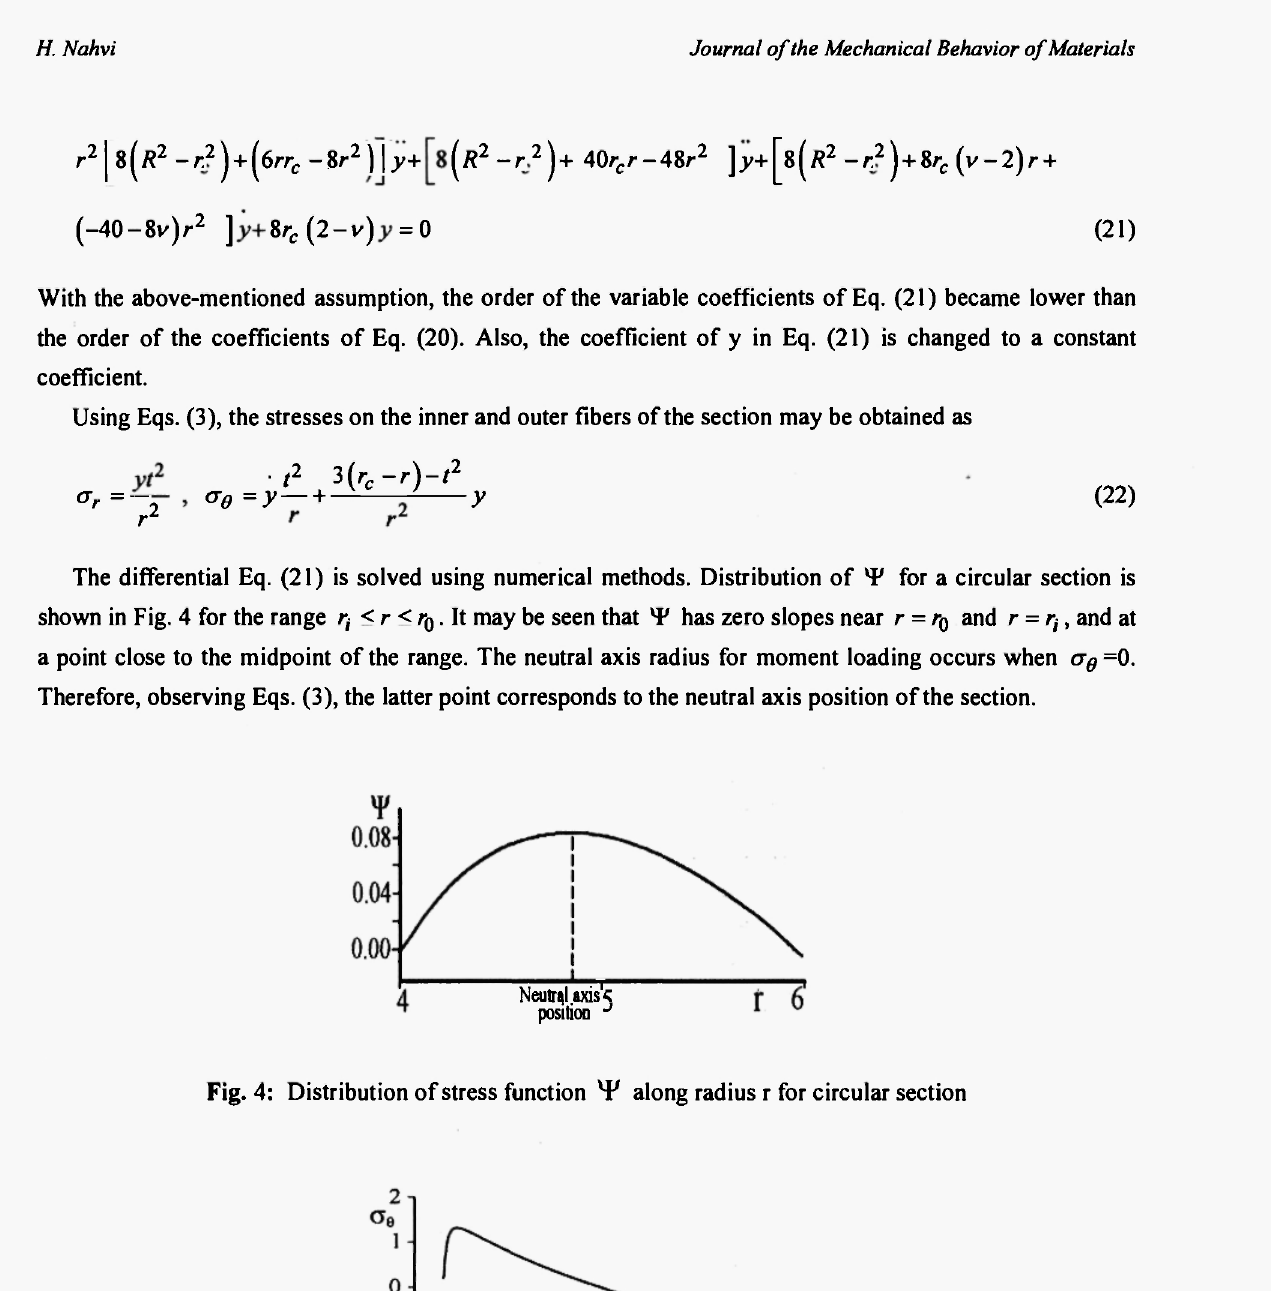
Fig. 4: Distribution of stress function Ψ along radius r for circular section